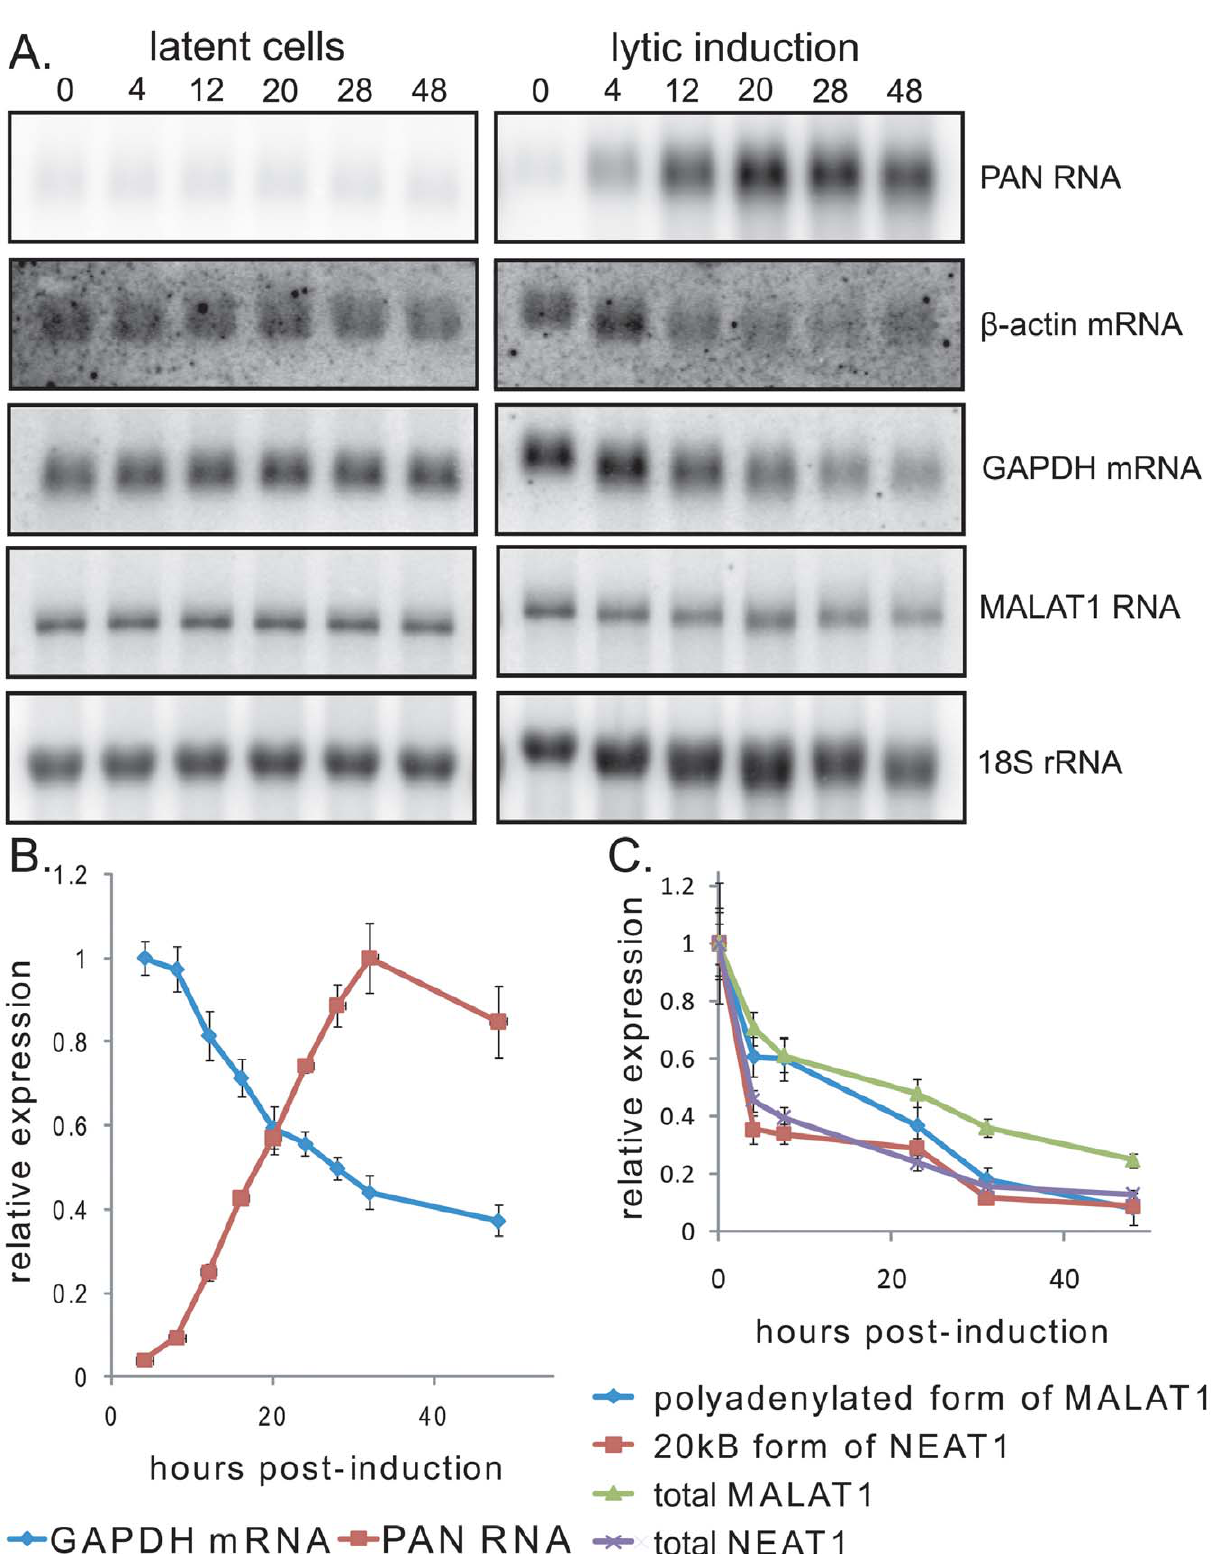
Figure 3. Expression of PAN RNA is coincident with the host shutoff effect. A. Northern blot showing host and viral RNA expression during progression of lytic reactivation by doxycycline treatment of BCBL1 TReX-vector (left) or BCBL1 TReX-RTA (right) cells. B. qRT-PCR data from a representative experiment showing increased expression of PAN RNA versus the decline in host GAPDH mRNA. C. qRT-PCR data from a representative experiment showing that host MALAT1 and NEAT1 RNAs decline during lytic infection. qRT-PCR signals were normalized to endogenous 18S rRNA.